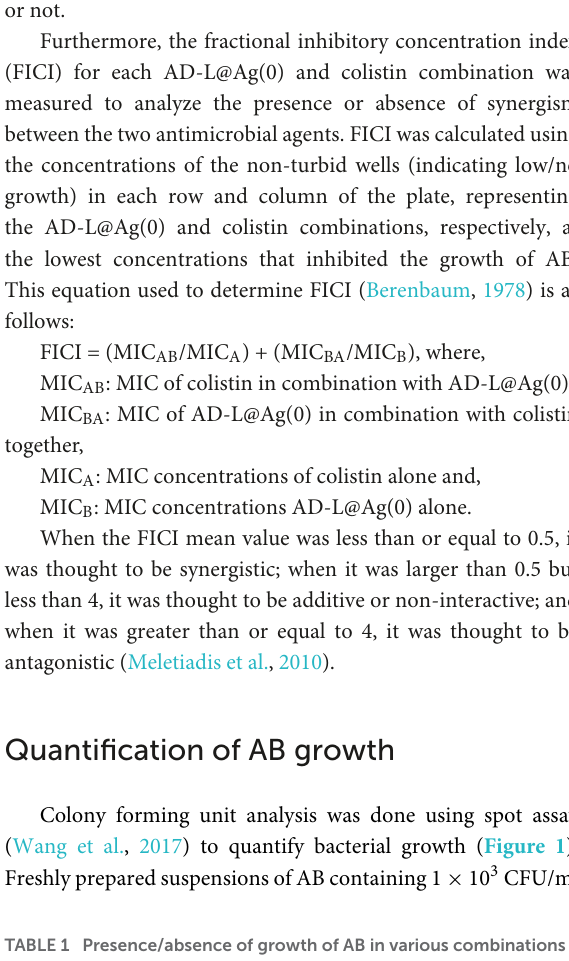
Concentration Growth ( µ g/ml) 2 +